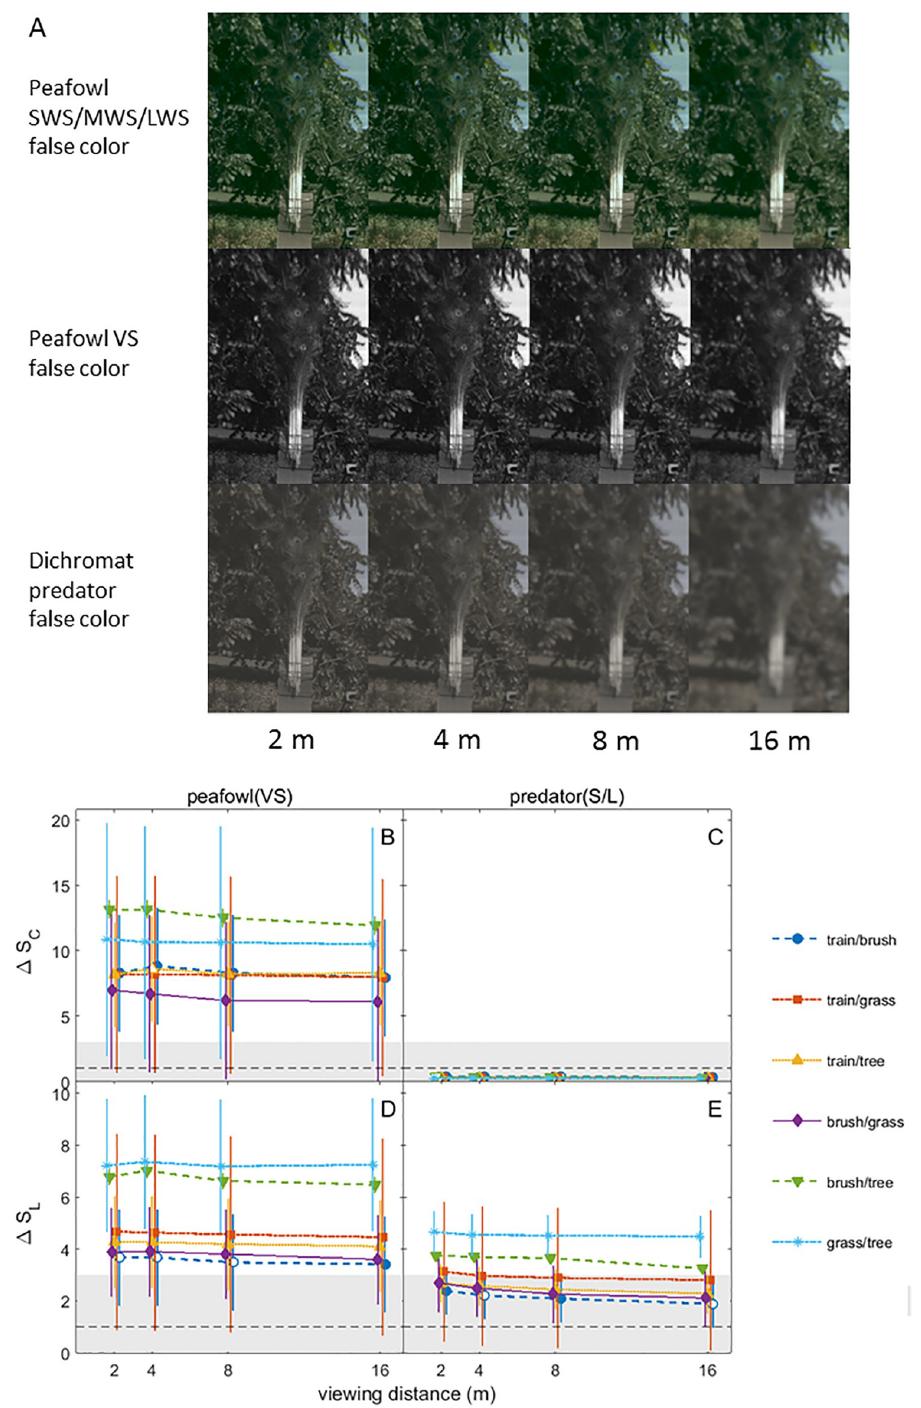
Fig 7. False color images and color and brightness contrast analysis of the peacock model train photographed against various types of vegetation backgrounds. (A) False color images in peafowl and dichromatic mammalian predator vision of peafowl model train for different viewing distances. (B)-(E) Color and luminance contrasts for the model train and features of vegetation, over a range of viewing distances. All data are shown as grand means with 95% CI error bars. See Fig 6 caption for further